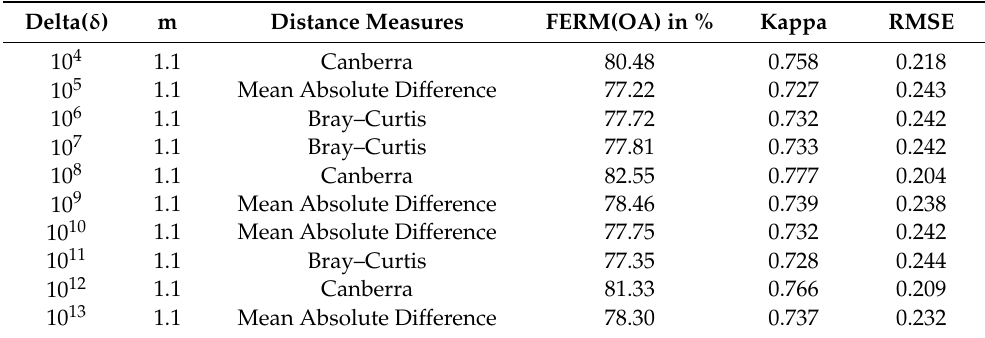
Table 2. Kappa and RMSE determined for the highest overall accuracy of the NC classifier by applying different parameters for site 1 (Haridwar).